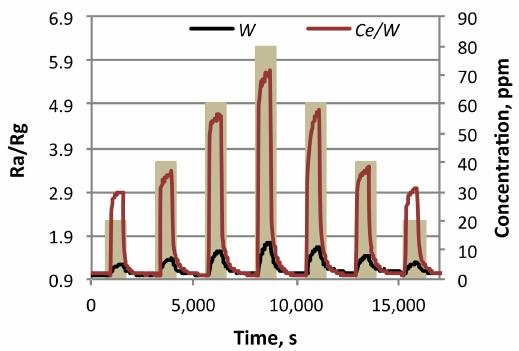
Figure 9. The sensor response to various concentrations (from 20 to 80 ppm) of acetone recorded with the W and Ce / W based sensors.